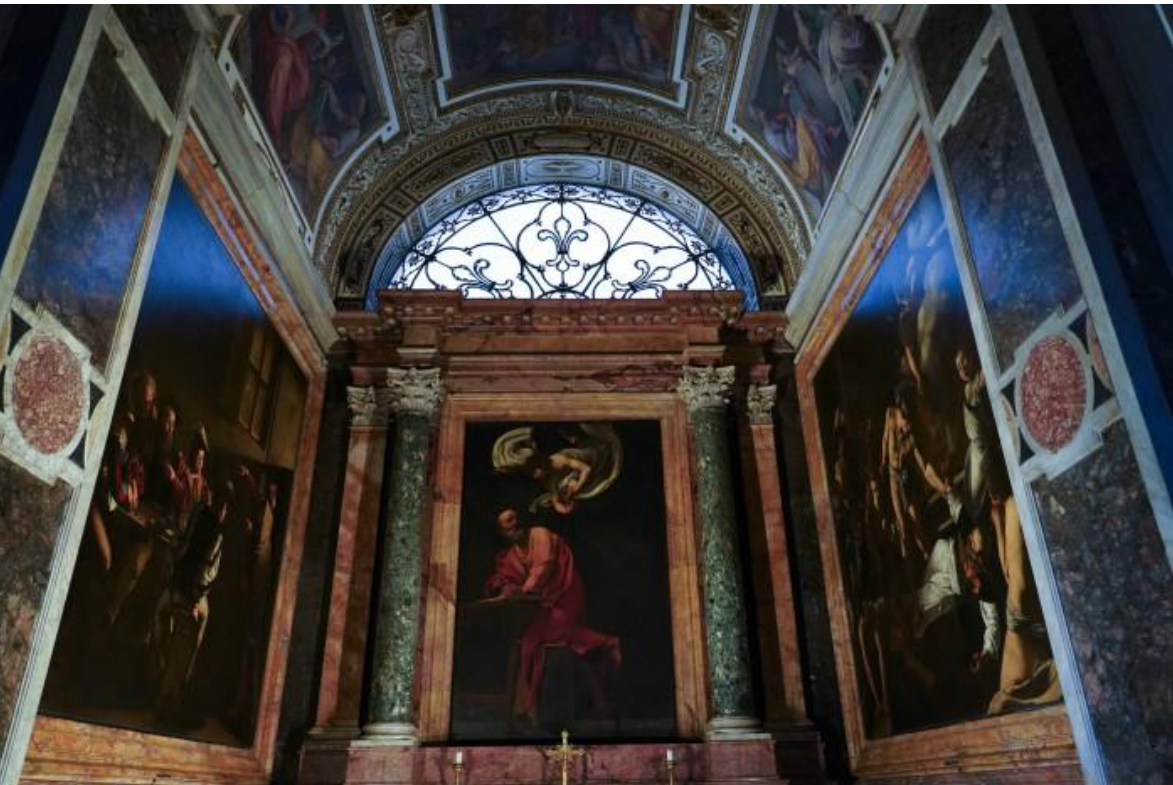
Figure 1. Caravaggio paintings, 17th century. Church of San Luigi dei Francesi, Rome, Italy. Photo in public domain.